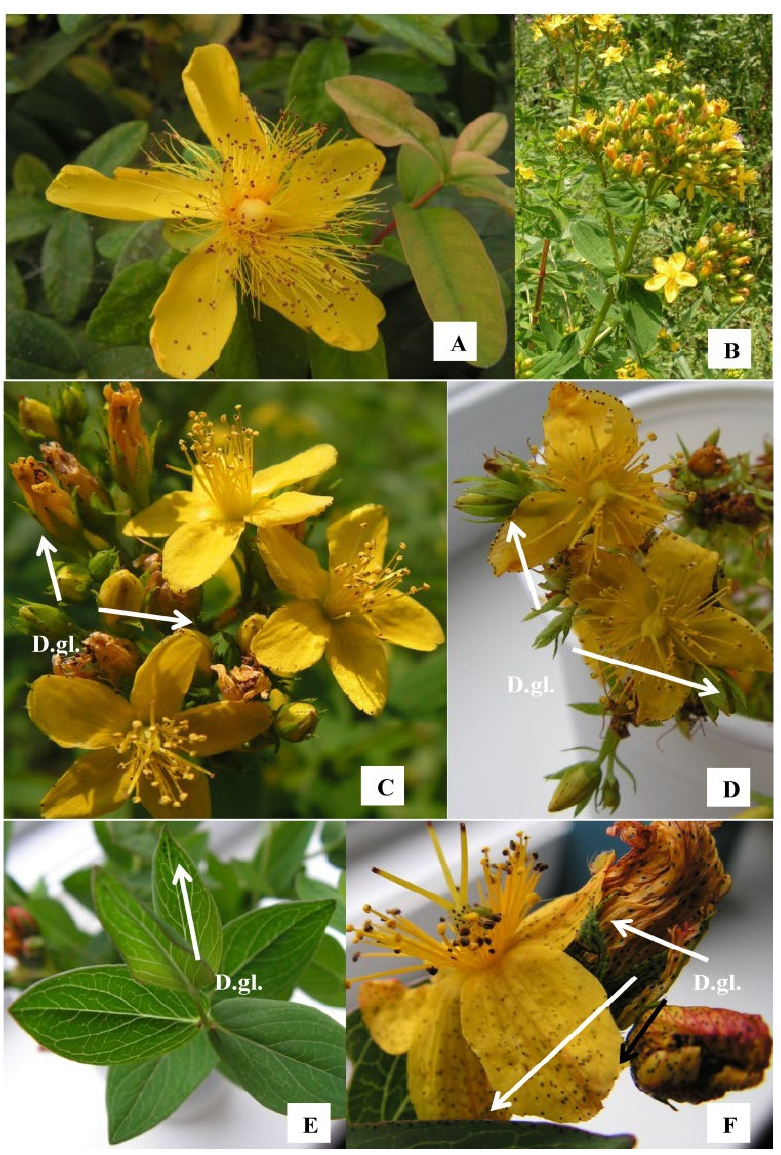
Figure 1. In situ growing H. calycinum L. ( A ); H. tetrapterum Fries. whole plant habitus ( B ) and blossoms with visible dark glands (D.gl.) on petal and sepal ribs ( C ); H. perforatum L. blossoms with dark glans ( D ); H. richeri Vill. leaves with scarce dark glands visible on leaves margins of non-blossoming aerial parts ( E ); and H. richeri Vill. blossoms with abundant dark glands visible on petals and sepals, as well as leaf ribs in proximity of blossoms ( F